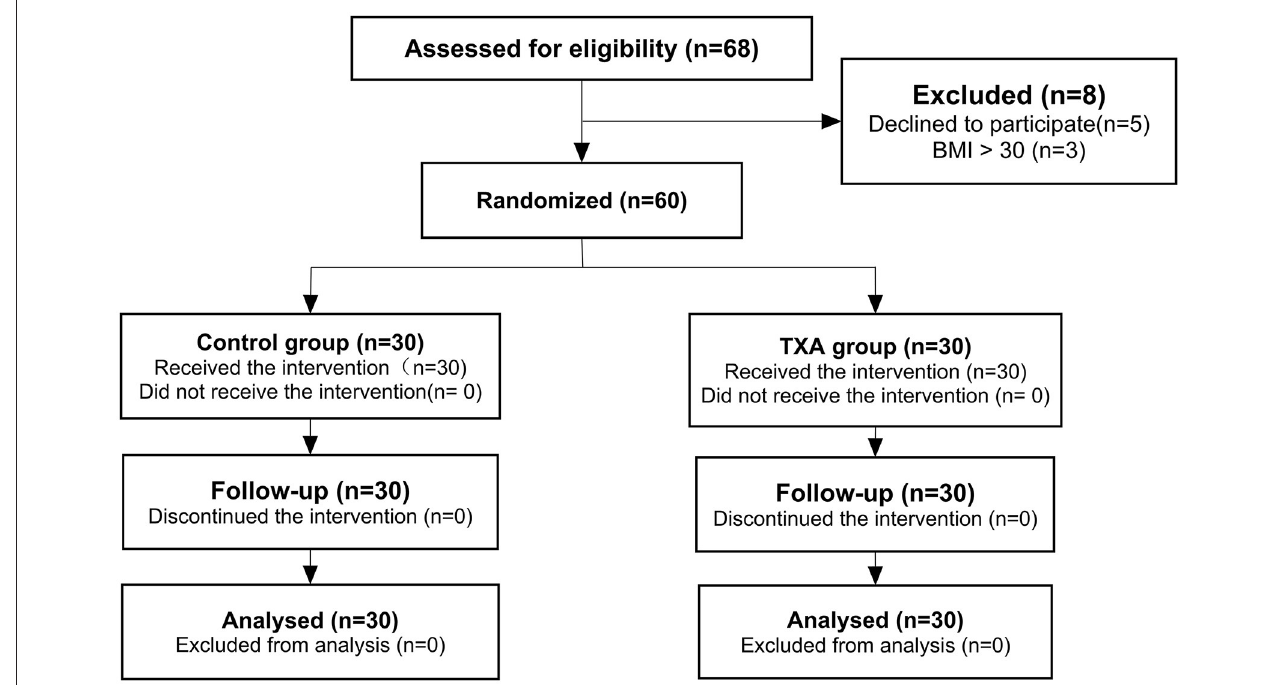
FIGURE 1 | Consolidated Standards of Reporting Trials (CONSORT) flow chart showing the flow of patients through the trial. TXA, tranexamic acid.